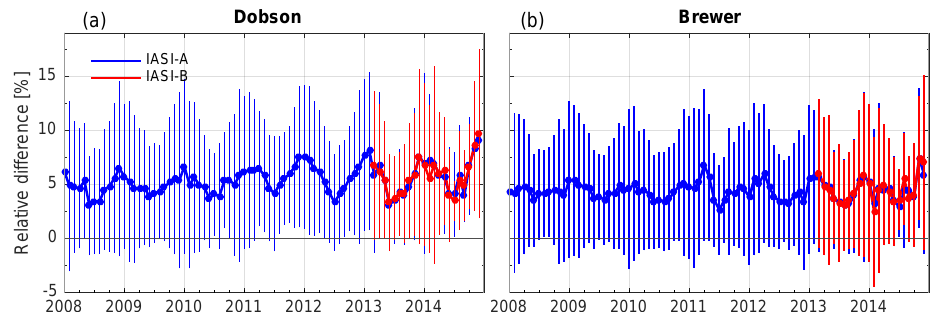
Figure 11. Monthly mean differences (in percent) between IASI-A (blue) and IASI-B (red) TOCs against co-located Dobson (a) and Brewer (b) spectrophotometer TOCs for the Northern Hemisphere. For the period March 2013 onwards, only the common co-locations between the two satellites are shown. The associated standard deviation of the monthly mean relative differences is also displayed.